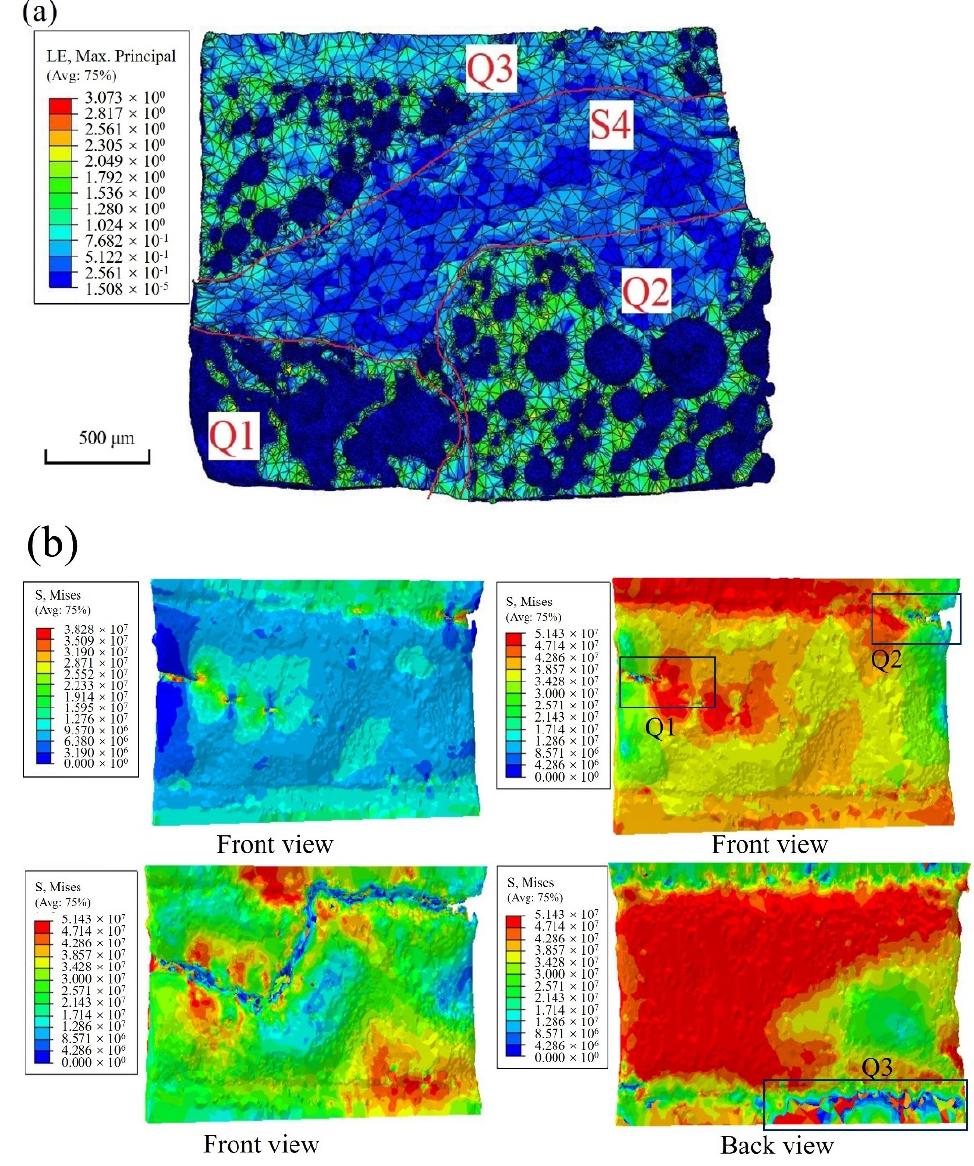
Figure 11. FE simulation results: ( a ) fracture morphology of solder joints; ( b ) process of crack initiation and propagation for solder joints.